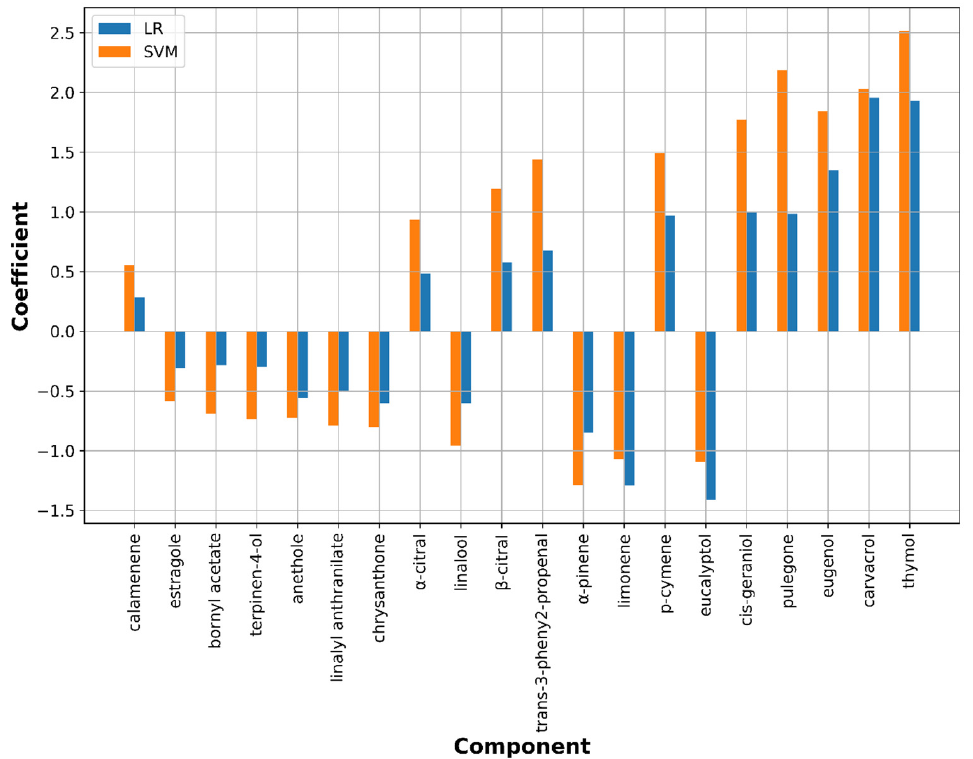
Figure 5. Linear coefficients for the LR and SVM ML-based models on M. gypseum. Only the first 20 most important compounds as in Figure 4 are